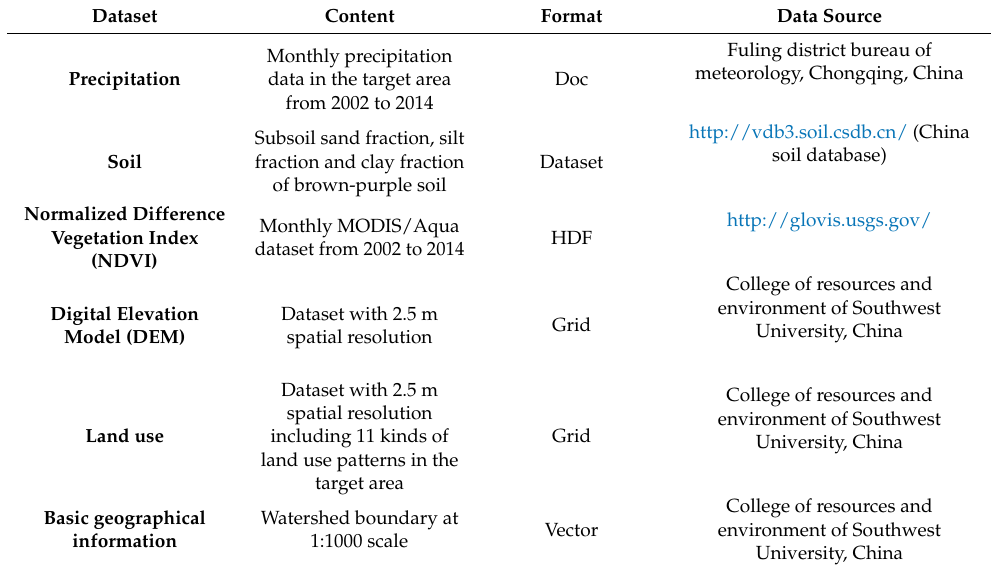
Table 1. The dataset